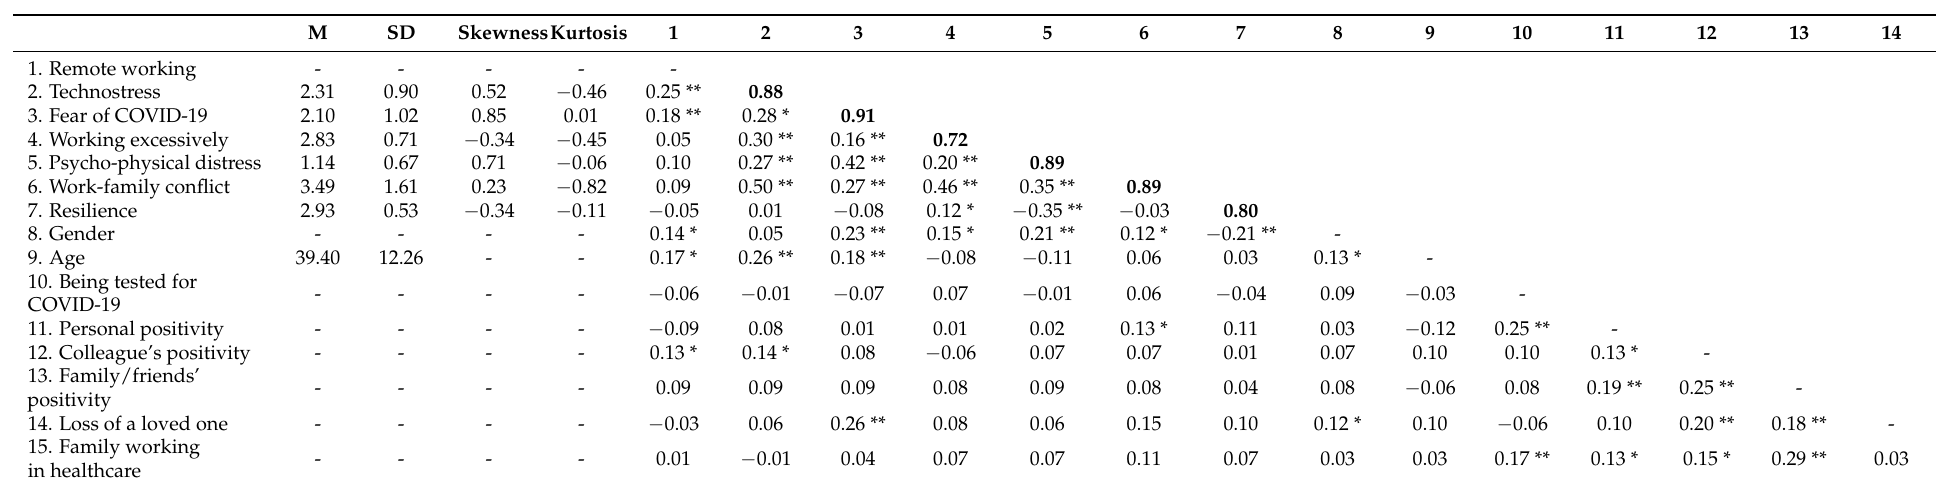
Table 1. Intercorrelations and descriptive statistics among study variables ( n =